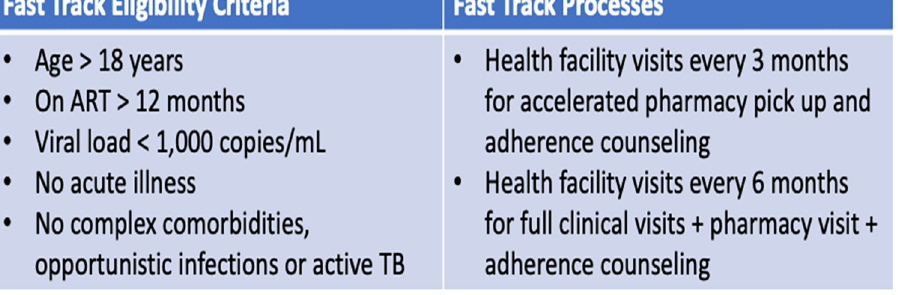
Fig 1. The fast -track HIV treatment model.